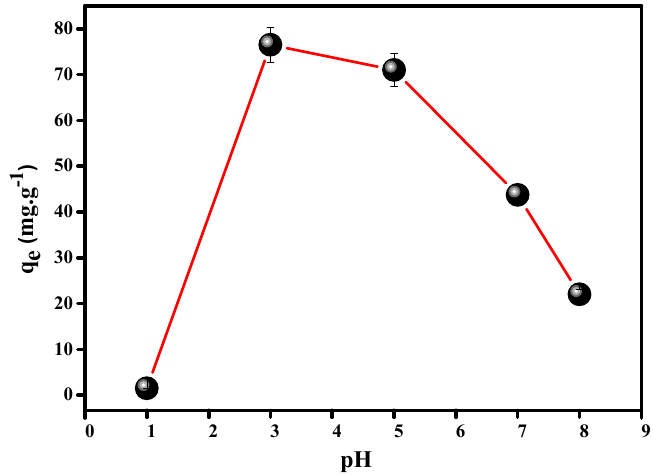
Figure 4. pH dependence of the adsorption capacity (mg.g − 1 ) of Cu ions.